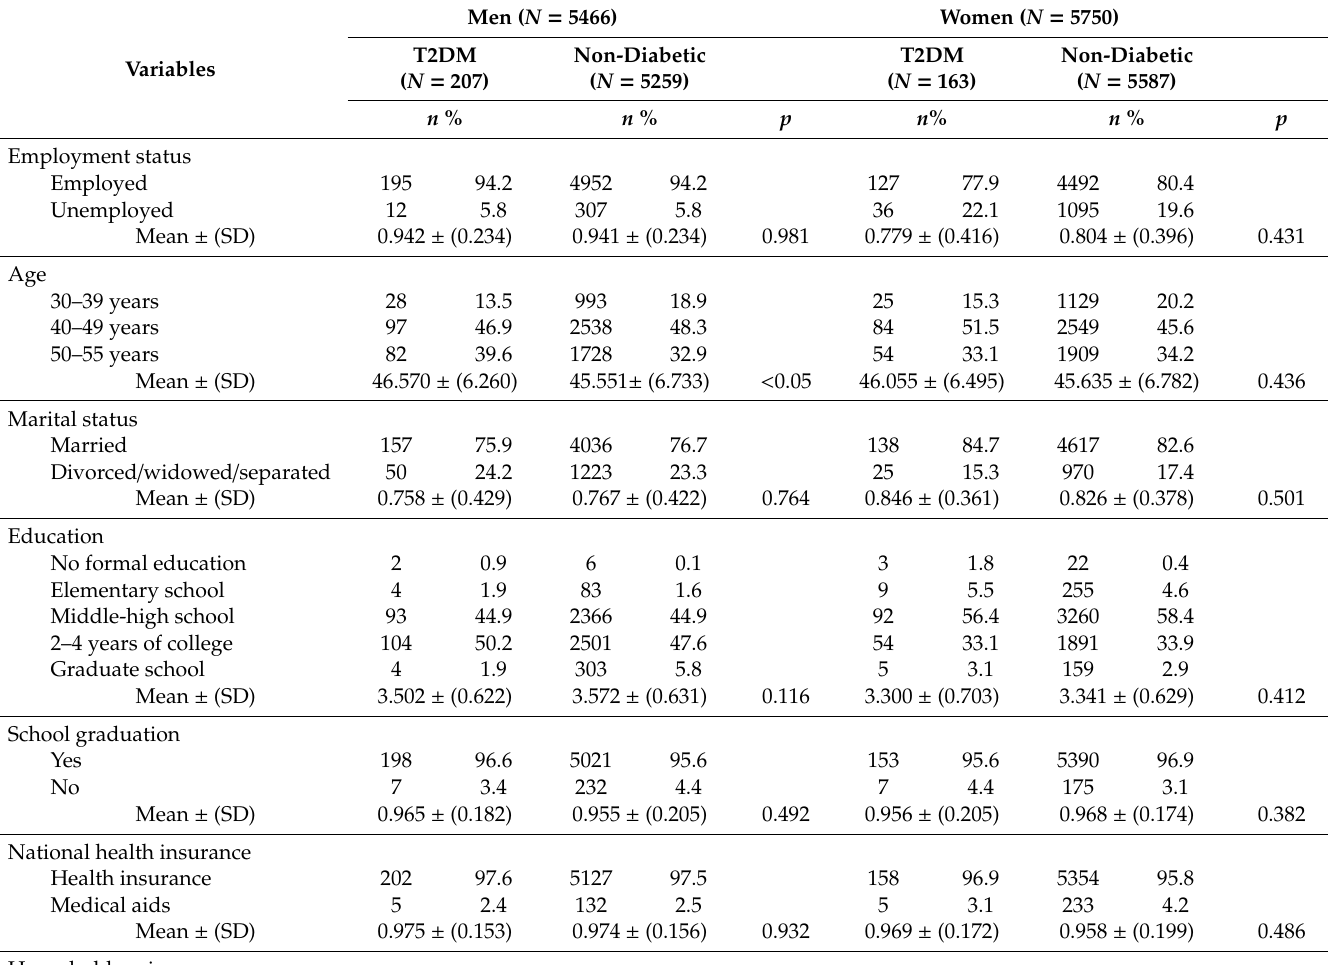
Table 2. Descriptive statistics by gender with and without type 2 diabetes mellitus (T2DM) in the Korea Health Panel Study, 2013–2015.